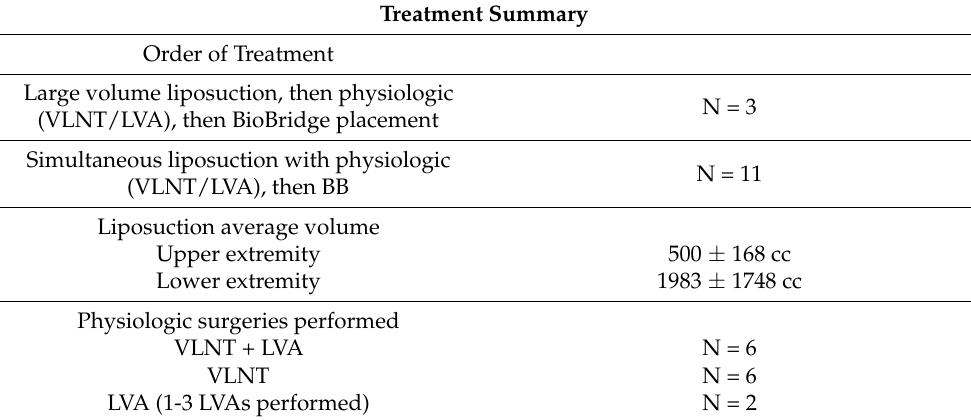
Table 2. Treatment